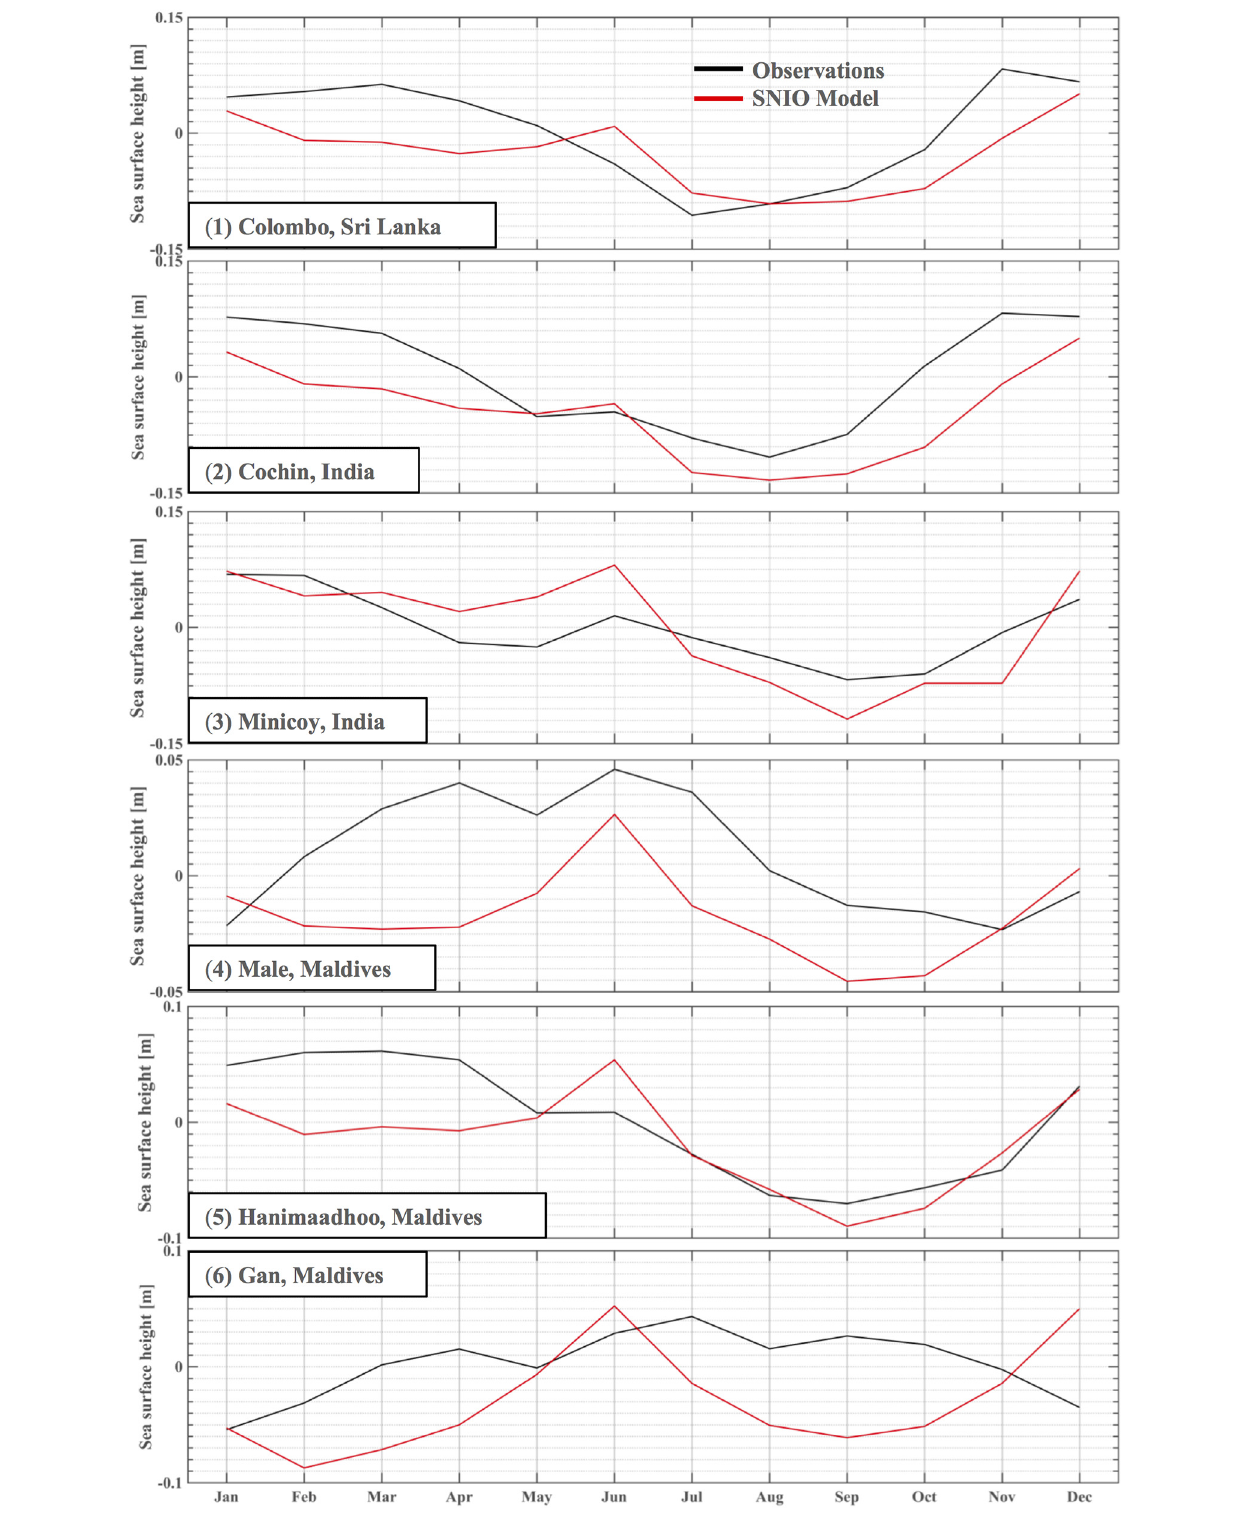
FIGURE 4 | Monthly climatology of observed sea level derived from UHSLC observations (black line) and SNIO model (red) from tide gauge locations at (1) Sri Lanka, Colombo (2) Cochin, India (3) Minicoy, India (4) Male, Maldives (5) Hanimaadhoo, Maldives (6) Gan, Maldives. All units are in (m).